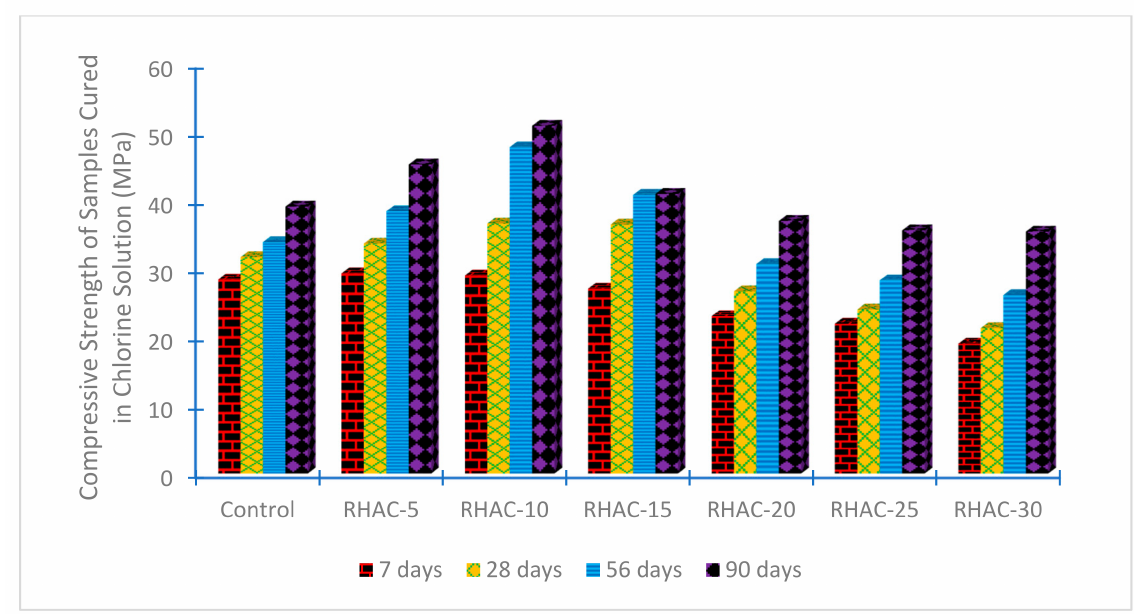
Figure 17. Compressive strength of RHA blended HPC cured in a chlorine